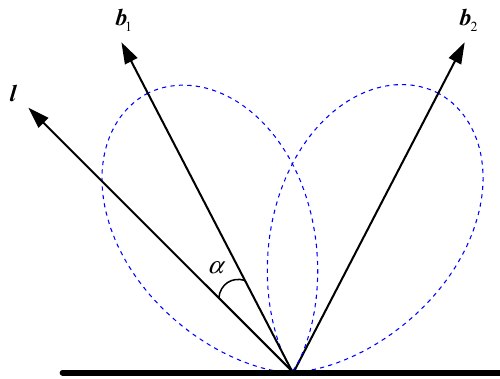
Figure 1. Gain pattern of the double-antenna-receiving system. Only the main lobes are shown in this figure.